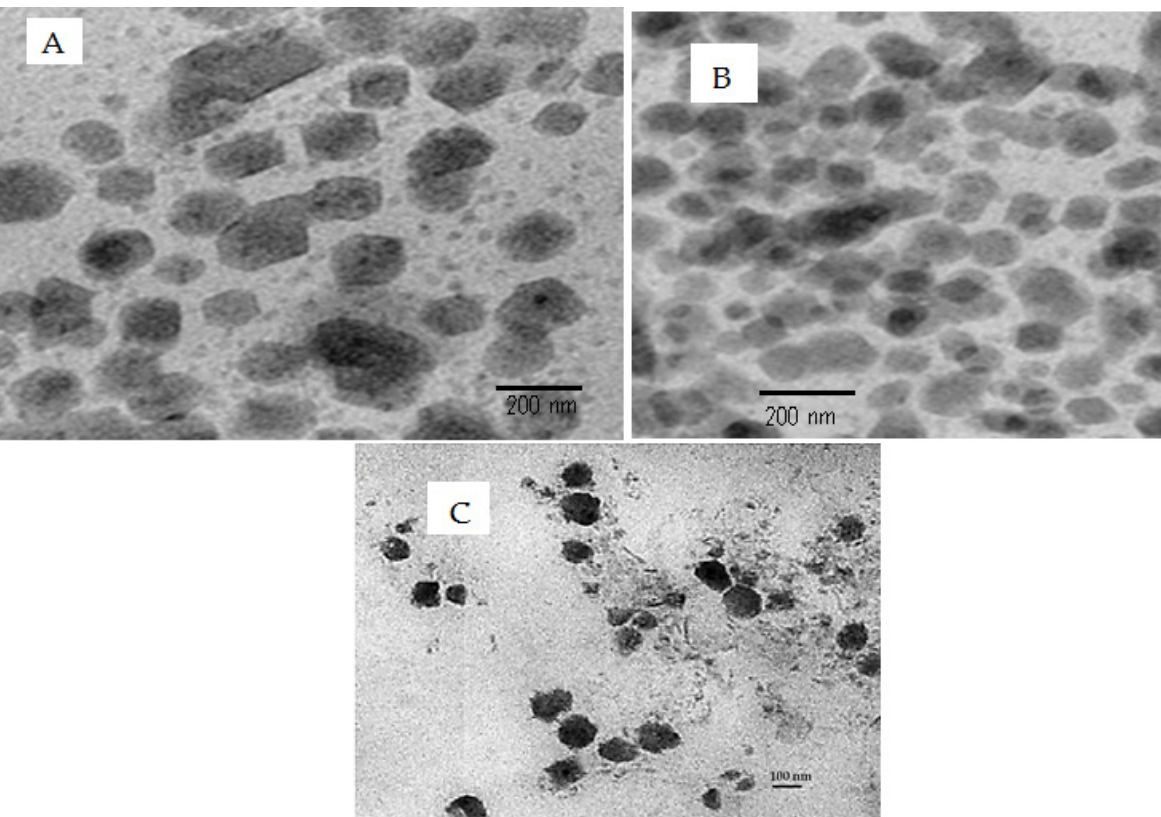
Figure 4. TEM micrograph of ( A ) GFT-CNP plain optimized formulation (GC9), ( B ) GFT-CNP, GC8, and ( C ) GFT-CNP optimized formulation (GC9).